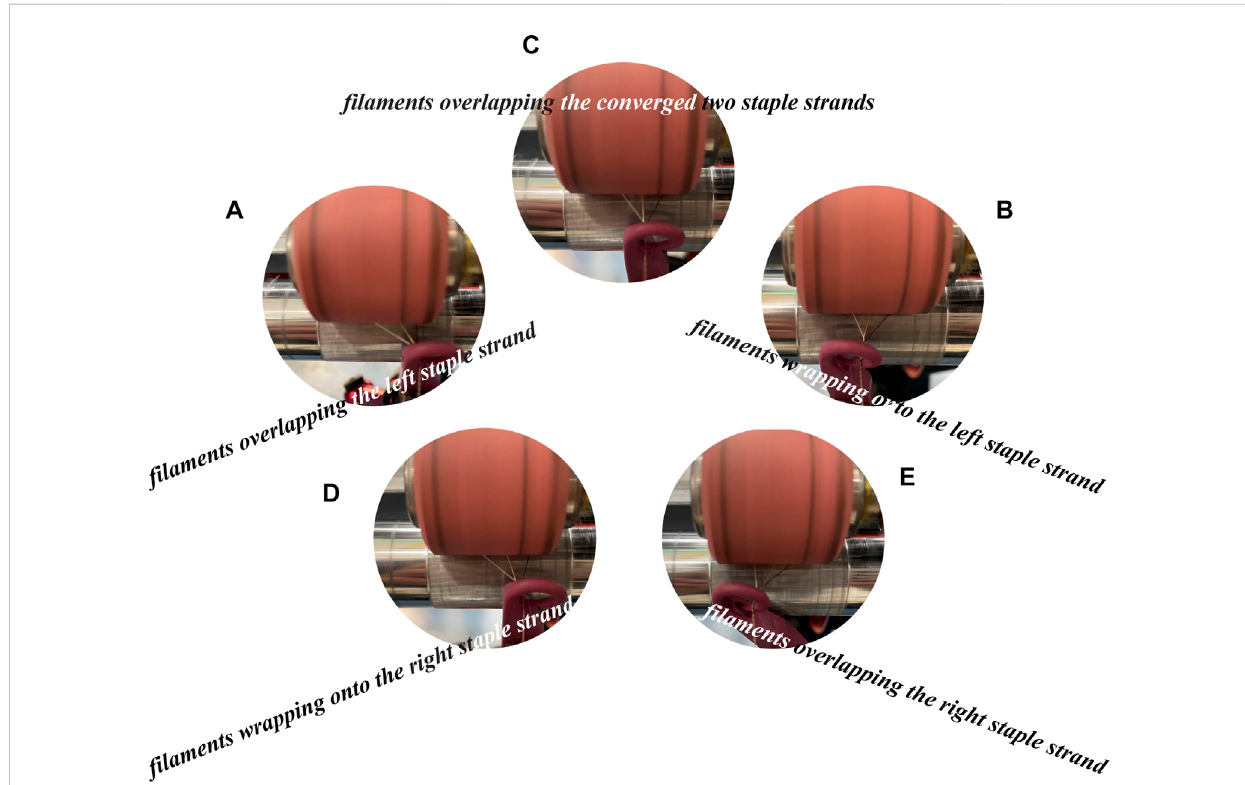
FIGURE 6 Forced migrations of combined fi laments during composite siro-spinning: (A) fi laments overlapping the left staple strand; (B) fi laments wrapping onto the left staple strand; (C) fi laments overlapping the converged two staple strands; (D) fi laments wrap-ping onto the right staple strand and (E) fi laments overlapping the right staple